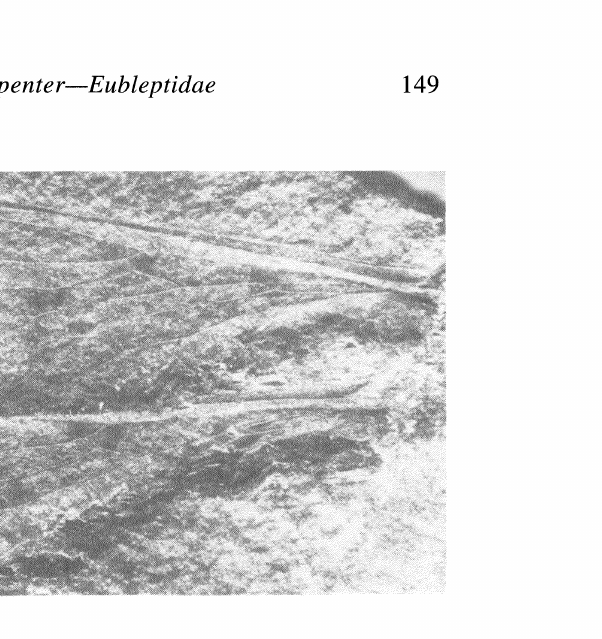
Figure 2. Eubleptus maculosus, n.sp. (type), showing dark